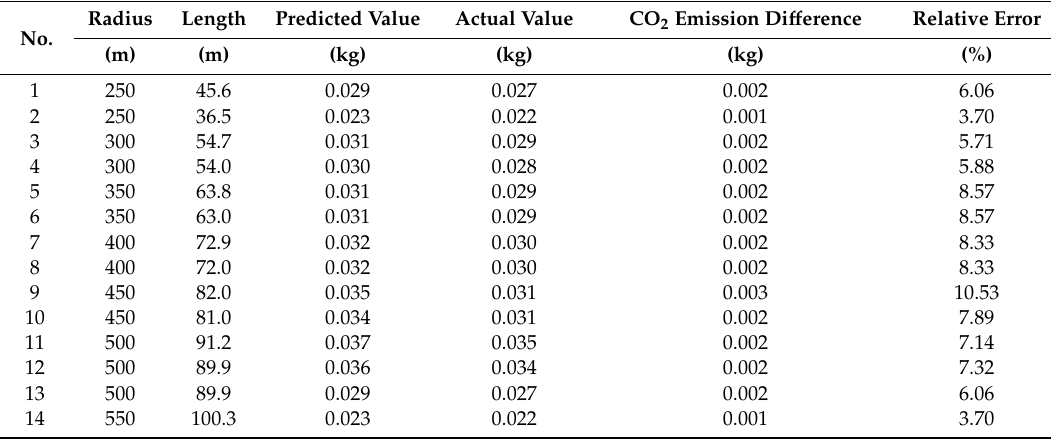
Table 8. Comparison of simulated and actual CO 2